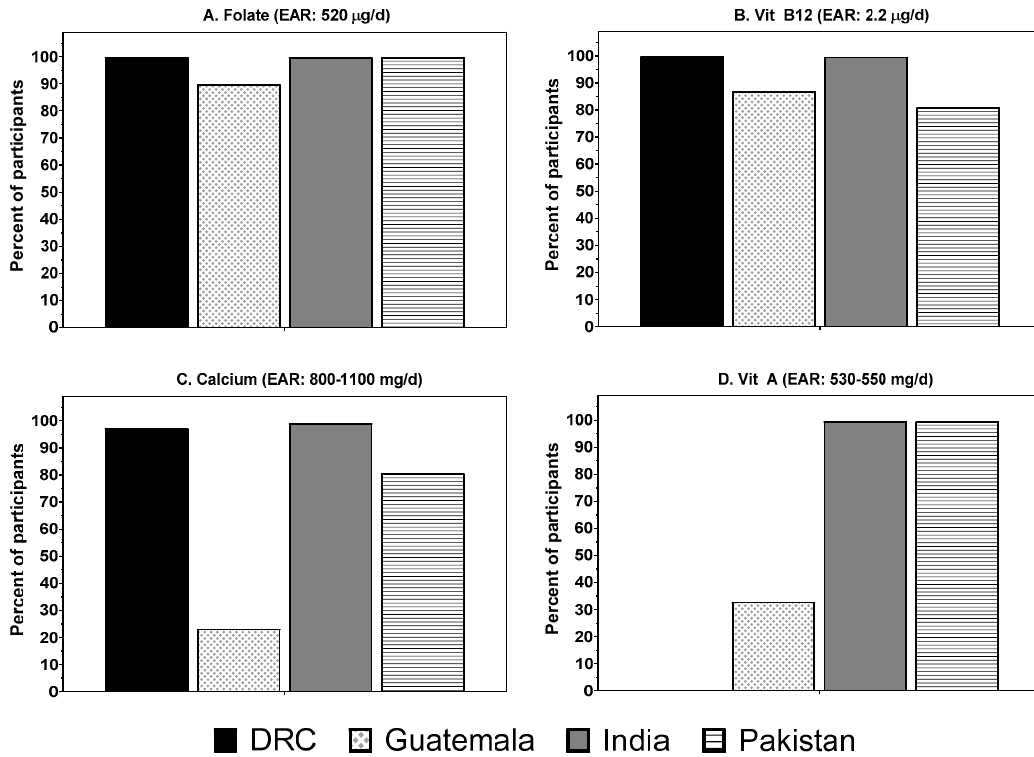
Figure 3. Estimated prevalence of the pregnant women in four low- and middle-income countries “at risk” of inadequate intakes of key micronutrients ( A ) Folate, ( B ) Vitamin B12, ( C ) Calcium, ( D ) Vitamin A. DRC, Democratic Republic of the Congo; Vit A, vitamin A; EAR, estimated average requirement; Vit B12, Vitamin B12.